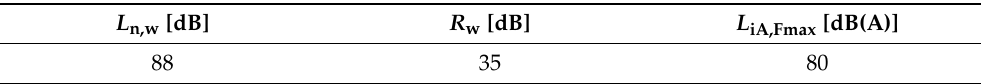
Table 3. Weighted normalized impact sound pressure level, L n,w , weighted sound reduction index, R w , and A-weighted energy average maximum impact sound pressure level measured with rubber ball according to the standard, L iA,Fmax